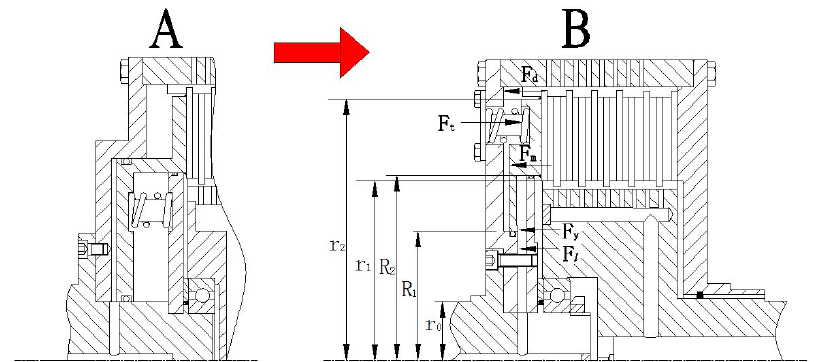
Figure 13. Comparison of two different types of HVC.